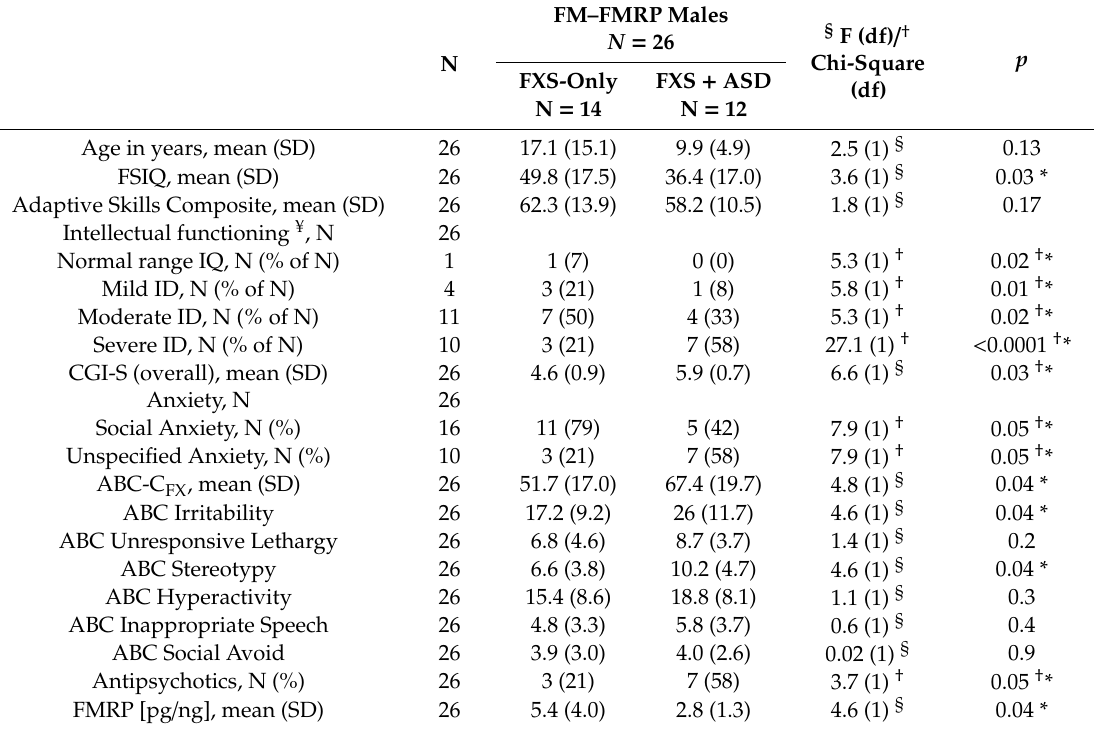
Table 6. Neurobehavioral profiles by ASD status in males in the FM–FMRP